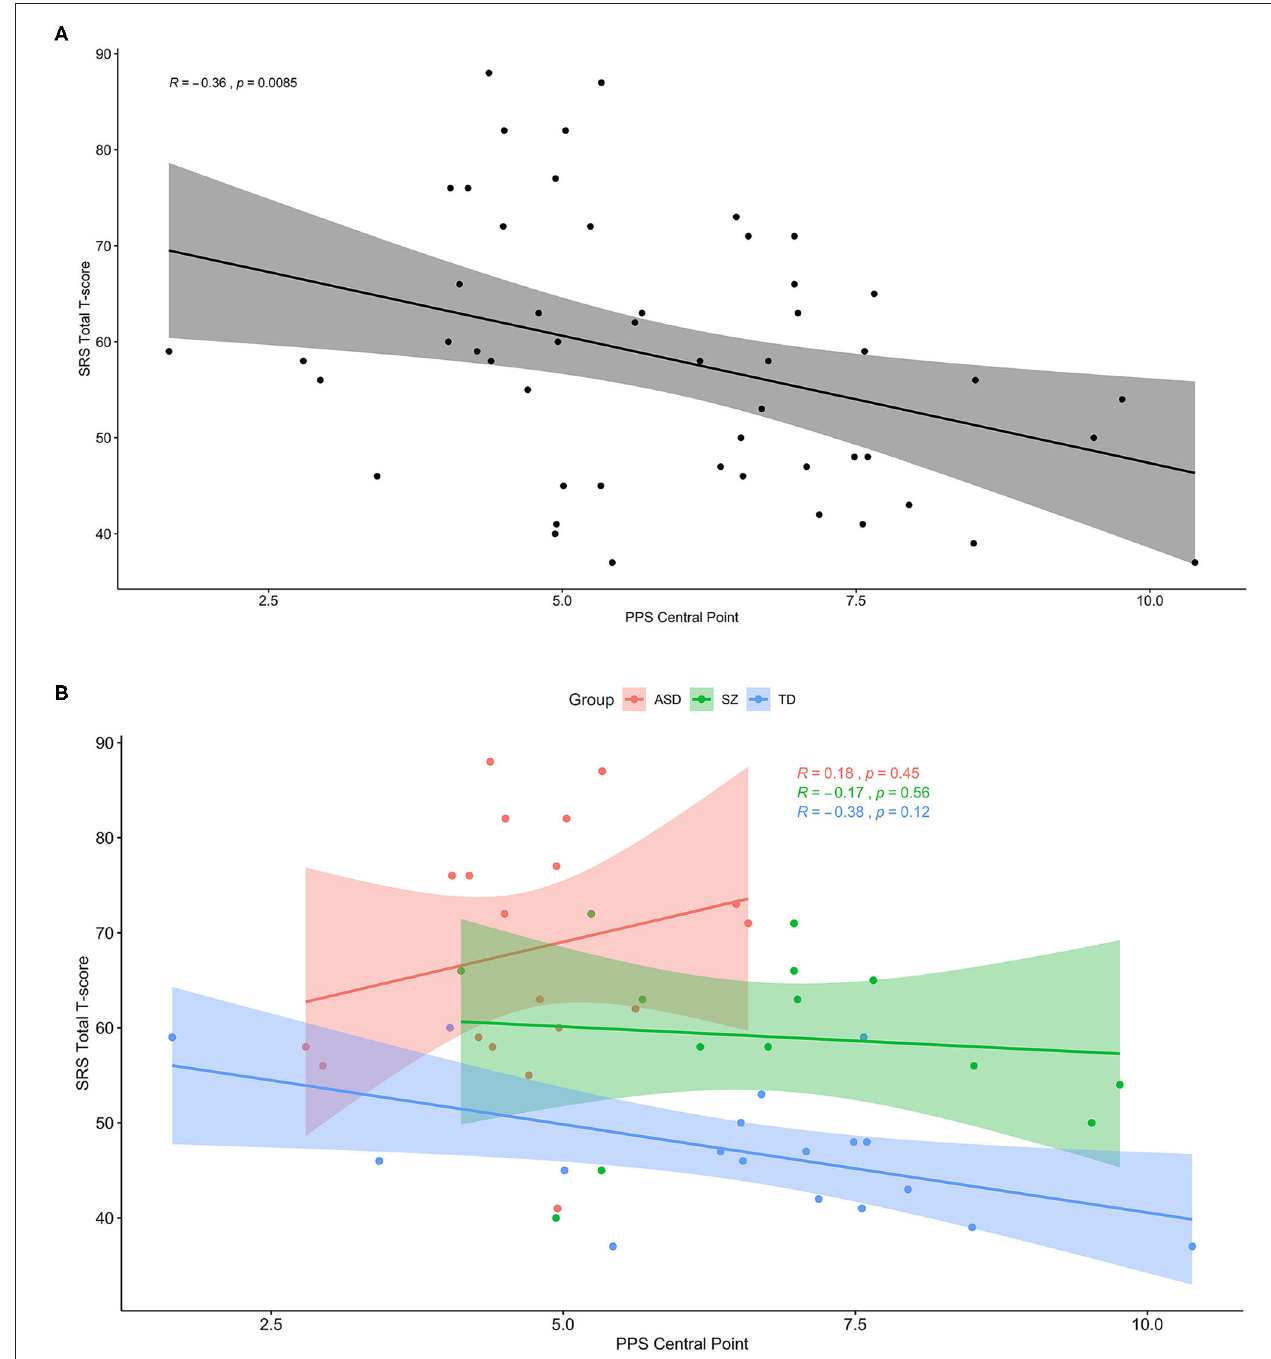
FIGURE 4 | Smaller PPS is associated with more social-communication deficit, but only in the subclinical range. (A) Across the whole sample, greater social-communication deficits as measured by the total T score of the SRS-2 was associated with smaller peripersonal space (PPS). (B) The same plot with groups separated by color (ASD: red, SZ: green, TD: blue), showing a trendline similar to that for the whole sample only within the TD group.